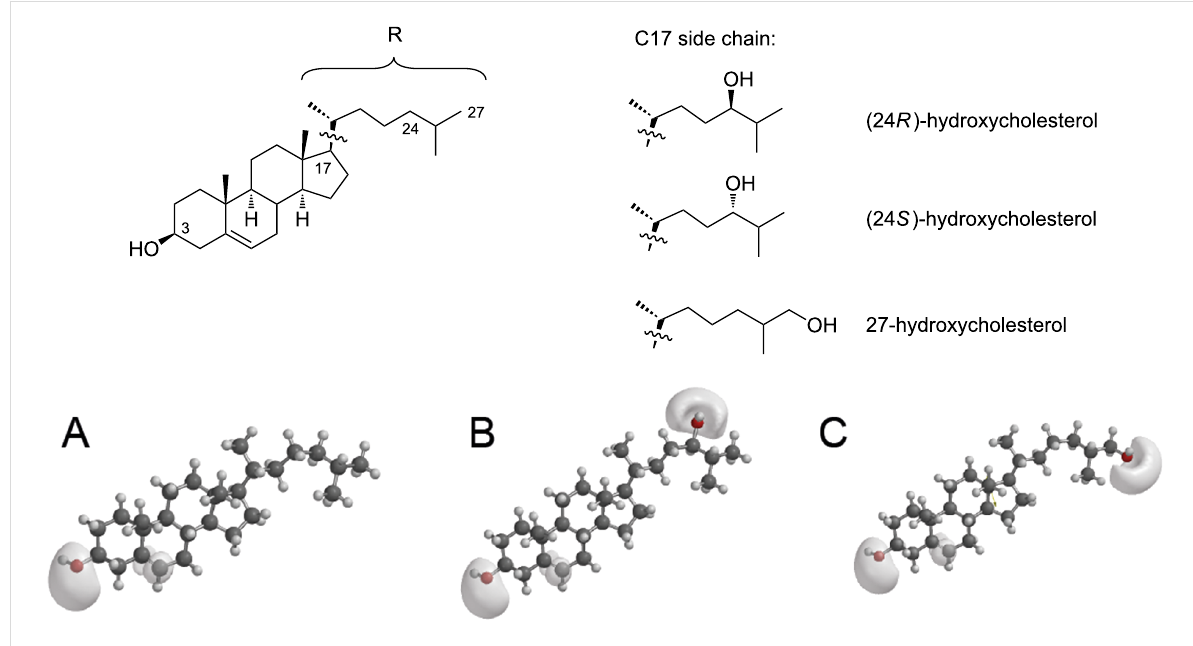
Figure 1: Top: Chemical structures of cholesterol and hydroxycholesterols with selected numbering for the carbon atoms. The investigated hydroxy- cholesterols are modified with an OH-group bound to the carbon in position 24 (either in R - or S -configuration) or in position 27, respectively. Bottom: Molecular models and isosurfaces of the electrostatic potential of cholesterol (A), (24 R )-hydroxycholesterol (B) and 27-hydroxycholesterol